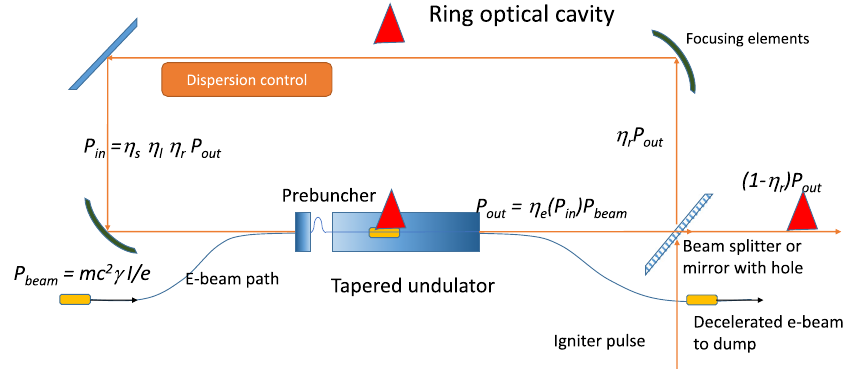
FIG. 1. Cartoon of the TESSO concept. A ringlike optical cavity is used to recirculate a small fraction of the electromagnetic radiation as a seed for the high efficiency decelerator. The cavity oscillation can be jump-started with an igniter